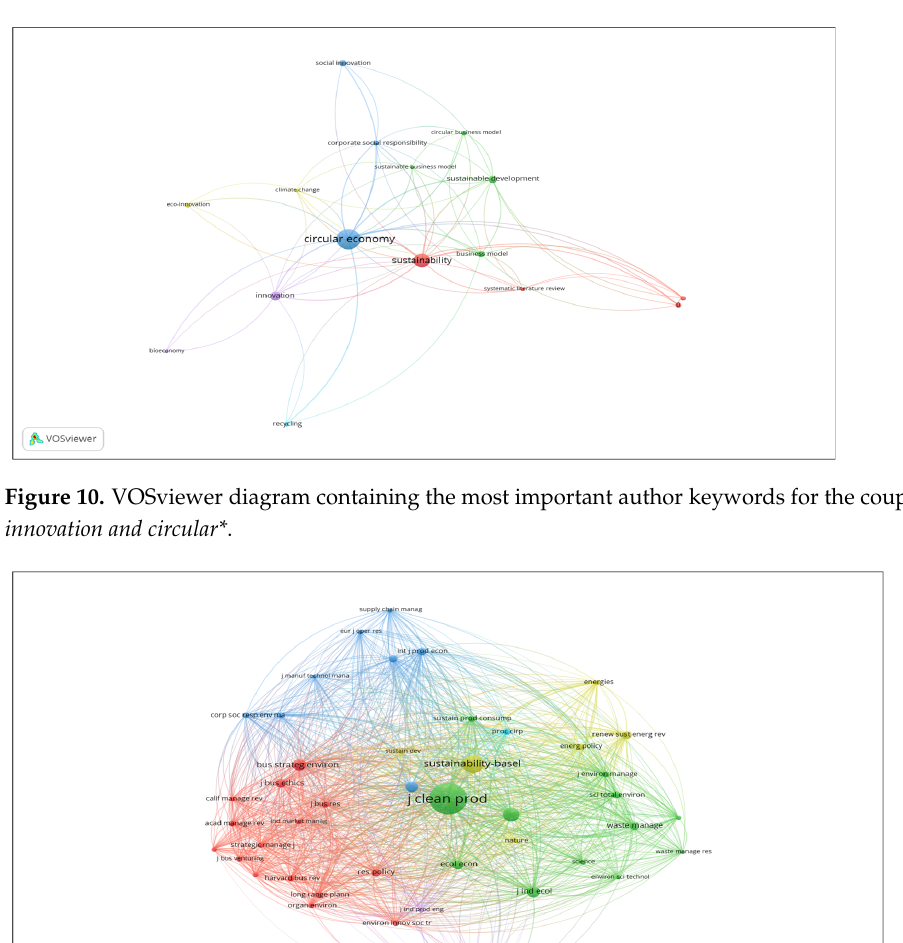
Figure 11. VOSviewer diagram containing the most cited journals for the couple: social innovation and circular*.